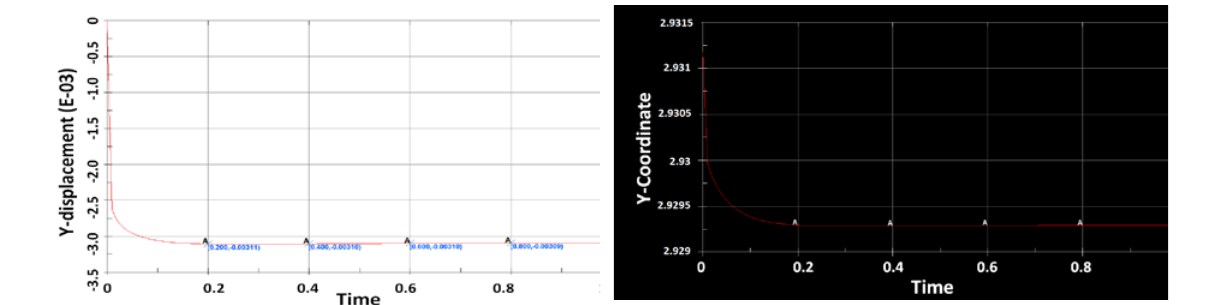
Figure 9: Vertical Y-coordinate system versus time for node